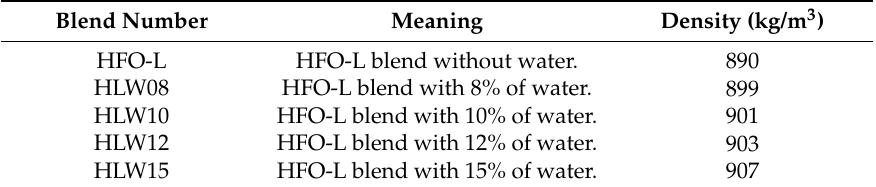
Table 4. The series of fuel blends used in the experiments. Water-emulsified HFO-L: HLW. Blend Number Meaning Density (kg/m 3 ) HFO-L HFO-L blend without water. 890 HLW08 HFO-L blend with 8% of water. 899 HLW10 HFO-L blend with 10% of water. 901 HLW12 HFO-L blend with 12% of water. 903 HLW15 HFO-L blend with 15% of water. 907